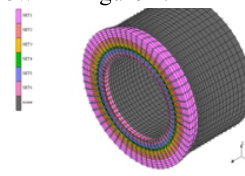
Figure 2. Generation of three-dimensional model